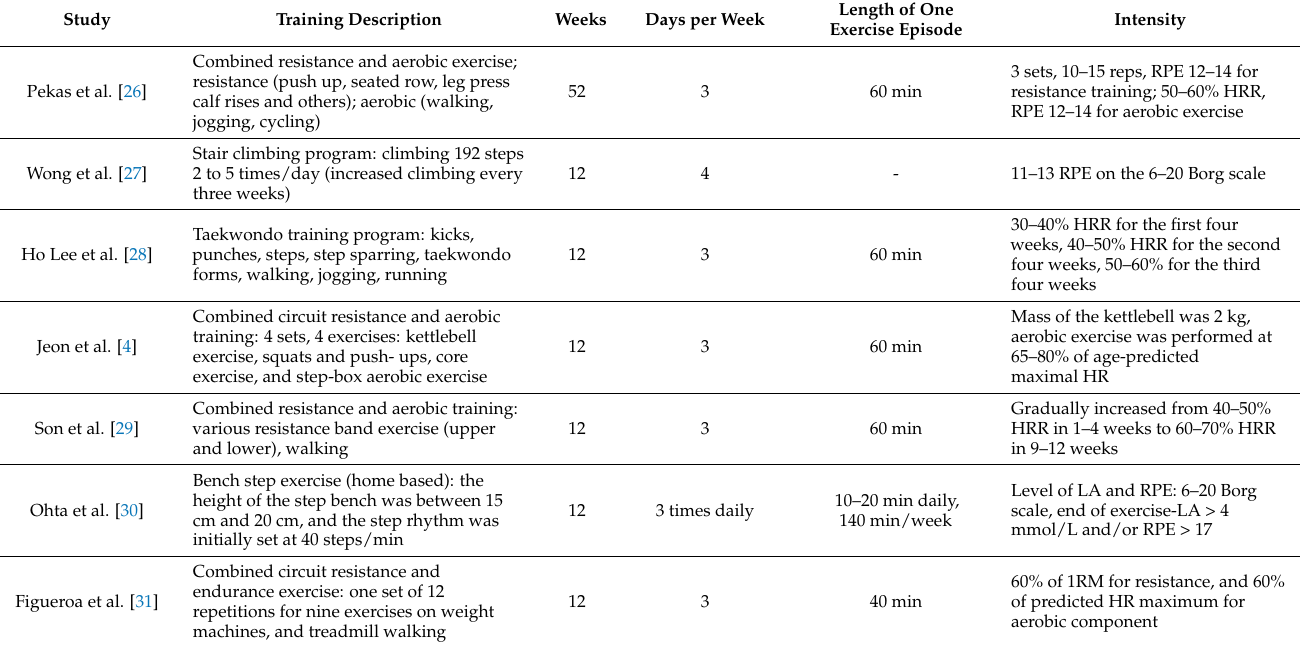
Table 3. Exercise